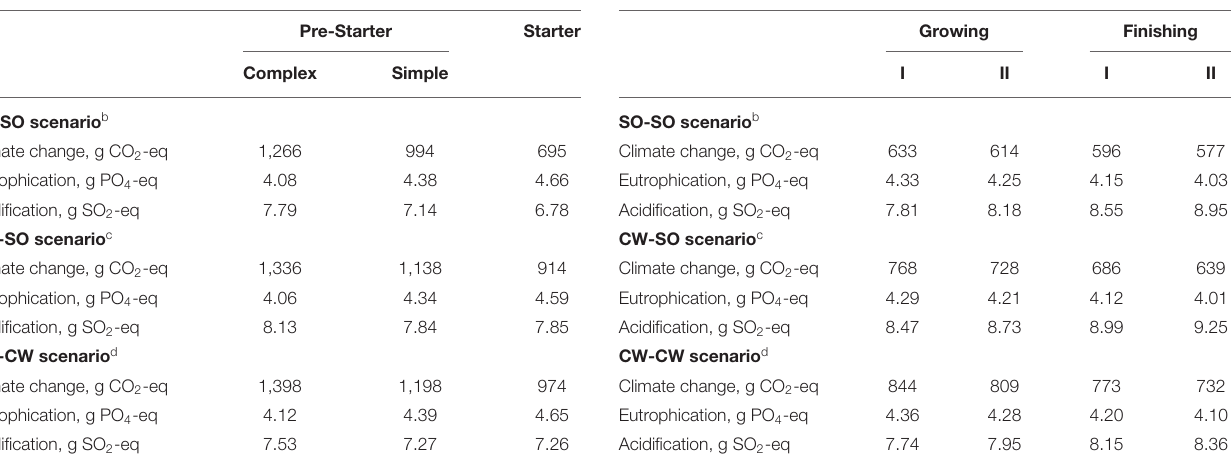
TABLE 6 | Potential environmental impacts of control feeds a (1kg at feed mill gate, formulated without β -mannanase) for growing-finishing pigs in different grain production scenarios.